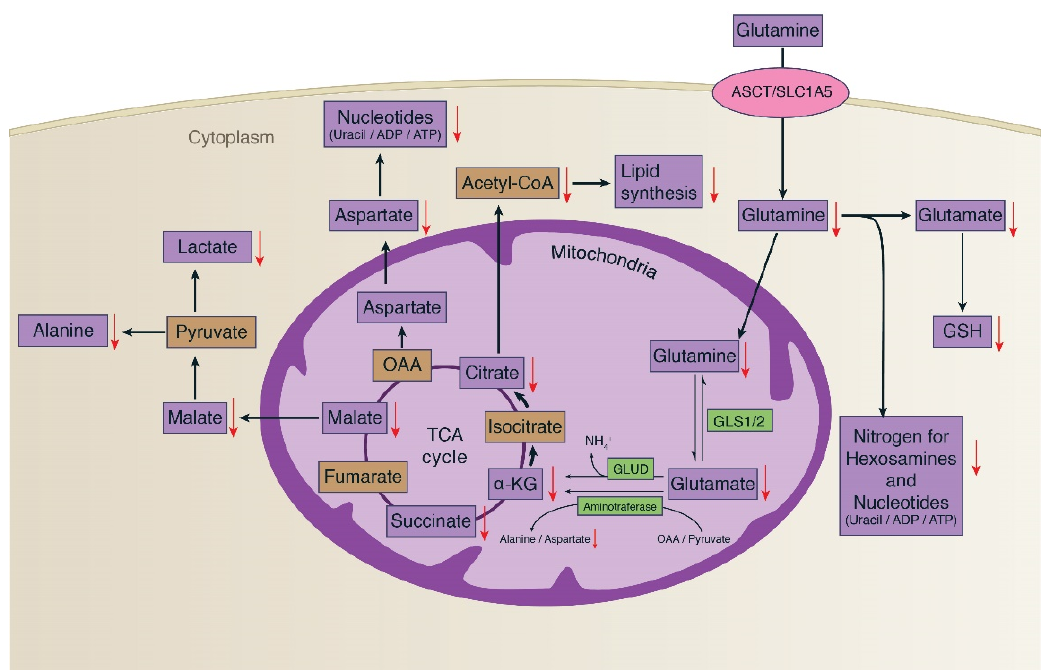
Figure 5. Glutamine metabolism and the effect of δT on glutamine metabolism in A549 and H1299 cells. Glutamine mainly replenishes the TCA cycle intermediates and GSH synthesis in cancer cell proliferation. In the process, glutaminase enzymes (GLS1/2) catalyzes the conversion of glutamine to glutamic acid and the subsequent conversion of glutamate to α-ketoglutarate (α-kG), catalyzed by glutamate dehydrogenase (GLUD) and amino transferase. This process supports for uncontrolled cell proliferation in cancer cells and requires a large number of macromolecules to create new biomass, including DNA, proteins, and lipids. The black arrows indicate the pathway’s direction, while the red downward arrows indicate the inhibition of metabolites as an effect of δT treatment.